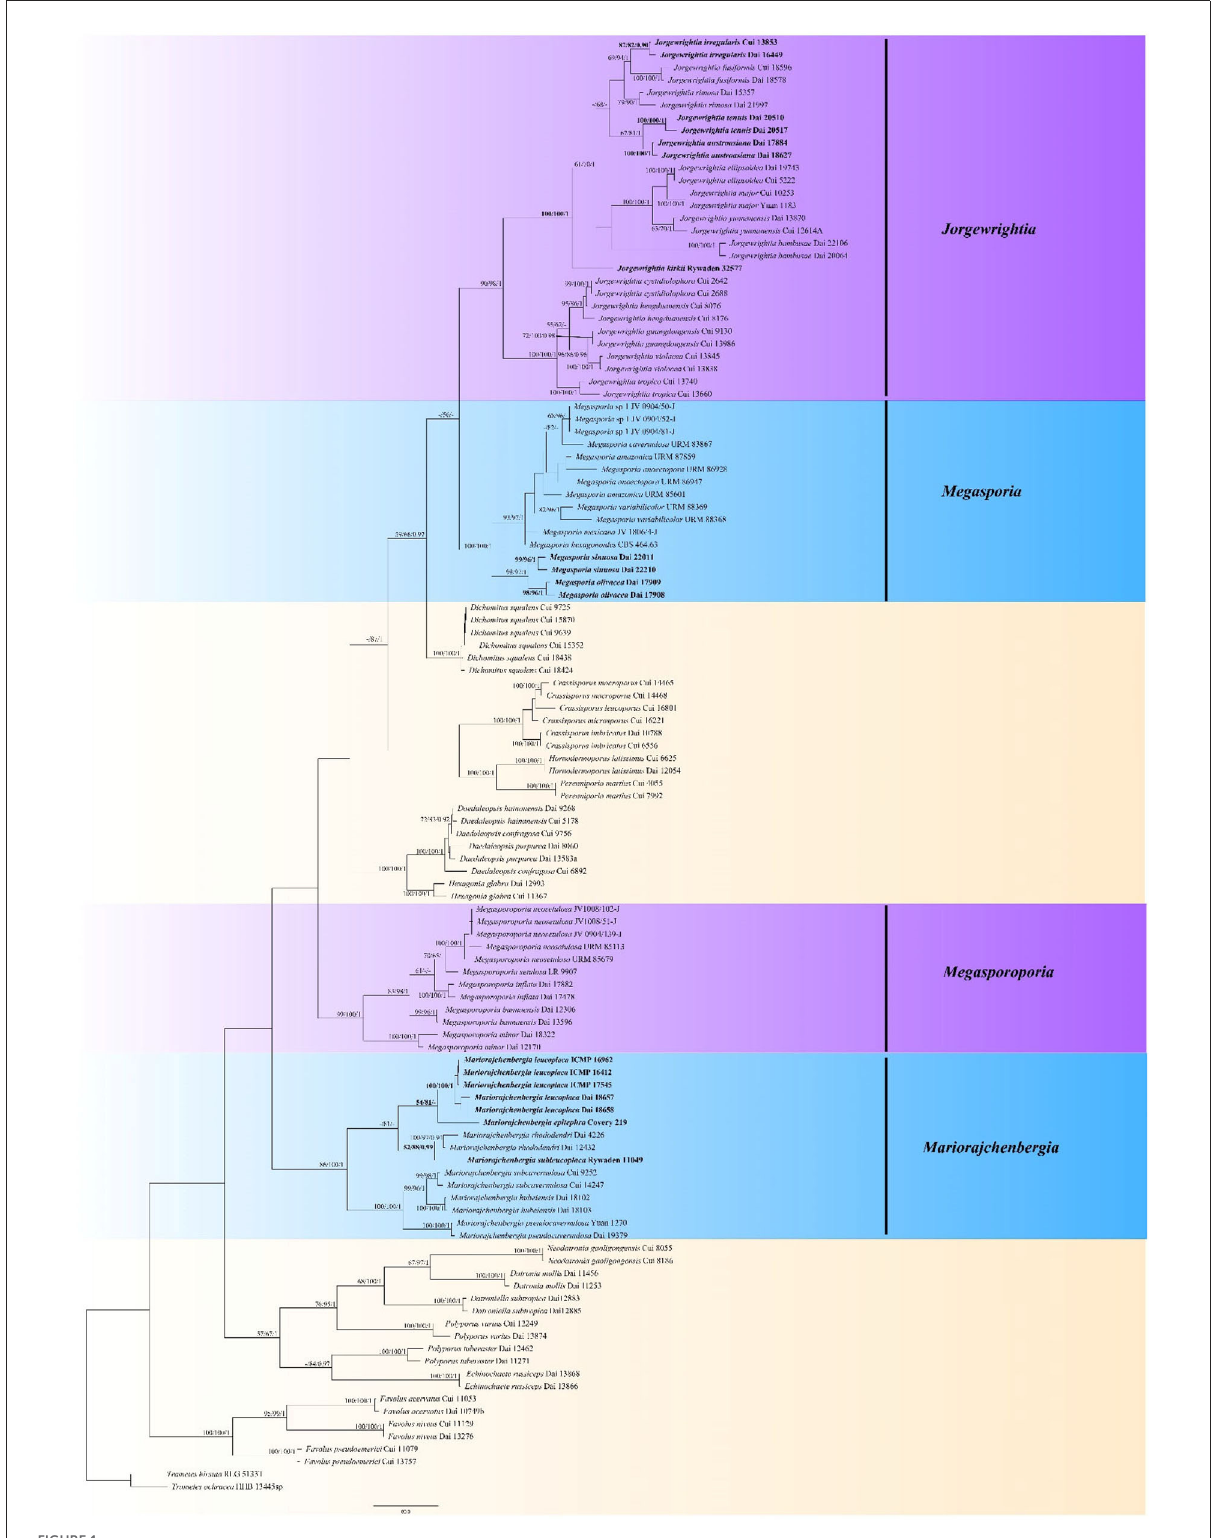
FIGURE1 Phylogeny of Megasporoporia sensu lato and related species generated by Maximum Parsimony (MP) based on combined ITS + nLSU + mtSSU + tef sequences. Bootstrap supports for Maximum Parsimony (MP), Maximum Likelihood (ML), and Bayesian Posterior Probabilities (BPP) were not lower than 50% (MP and ML) and 0.90 (BPP) on the branches. The new species and new combinations are in